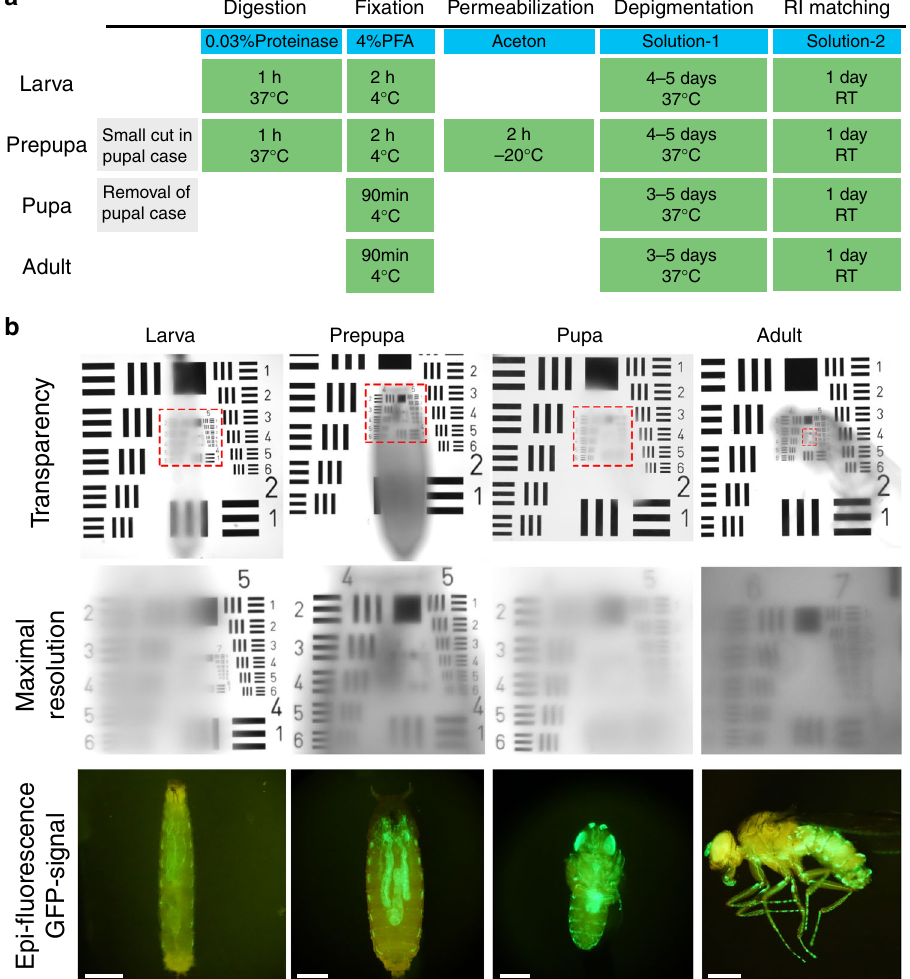
Fig. 1 Work fl ow and properties of the FlyClear procedure. a Main steps of the FlyClear protocol. b Upper panel shows wide- fi eld image of optically cleared specimens placed on top of a USAF1951-chart in Solution-2 demonstrates the level of overall transparency. Middle panel shows higher magni fi cation of red rectangular areas indicating the highest level of transparency reached in the corresponding sample. Lower panel shows GFP signal after RI matching. Bright fi eld images were acquired with a 4x objective (Olympus, XLFluor4x/340, 0.28 NA, WD = 29.5 mm) using custom-made correction of optics for a refractive index of 1.45 (WD = 10 mm after correction). Fluorescent images were acquired with a stereomicroscope with a 1x objective (Leica, Plan APO 1.0×, WD 61.5 mm). Genotype: Peb-Gal4 UAS-mCD8::GFP; . Scale bars represent 500 µ m in